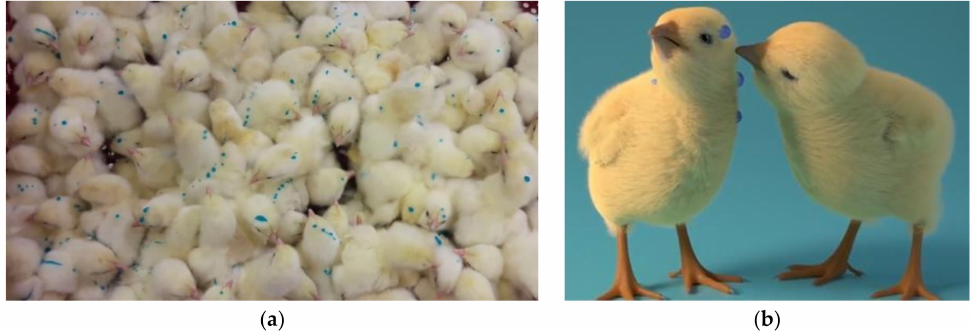
Figure 1. ( a ) Post-hatch administration of PoultryStar ® Hatchery EU (source: Biomin); ( b ) Chicks’ mutual grooming triggered by PoultryStar ® Hatchery EU . Table 1. Basal diet composition according to the feeding